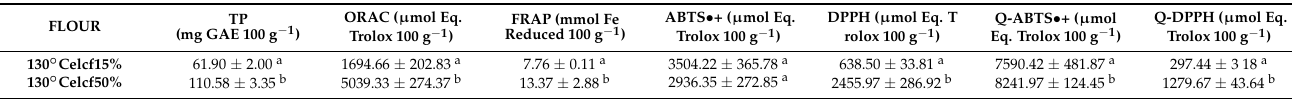
Table 5. Total phenol (TP, mg GAE 100 g − 1 dry matter), total antioxidant activity as ORAC, ABTS • +, DPPH ( µ mol